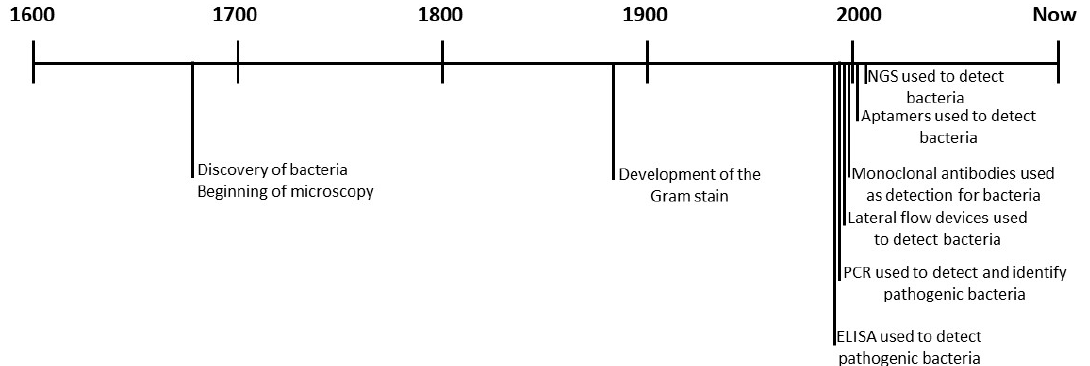
Figure 1. Timeline of development of bacterial detection systems. Figure 1 shows the timeline of the development of bacterial detection systems using different technologies, 1676—Discovery of bacteria and beginning of microscopy [68], 1883—development of the Gram stain [68], 1980—ELISA used to detect pathogenic bacteria [69], 1988—PCR used to detect bacteria [70], 1999—Lateral flow detection of bacteria [71], 1999—Monoclonal antibody detection of bacteria [72], 1999–2000s–Aptamer detection of bacteria [73], 2009—NGS detection of bacteria